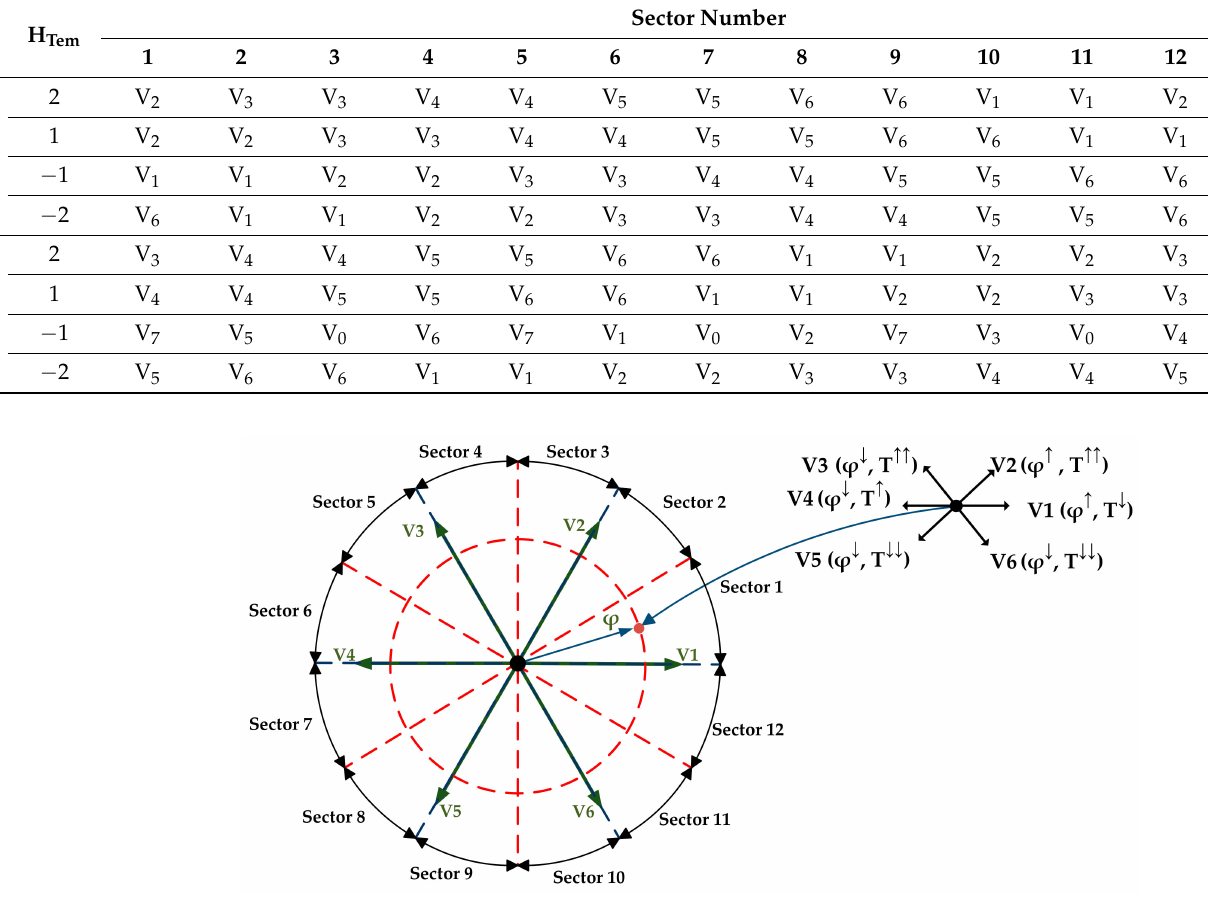
Figure 14. Voltage vectors in the proposed 12-sectors